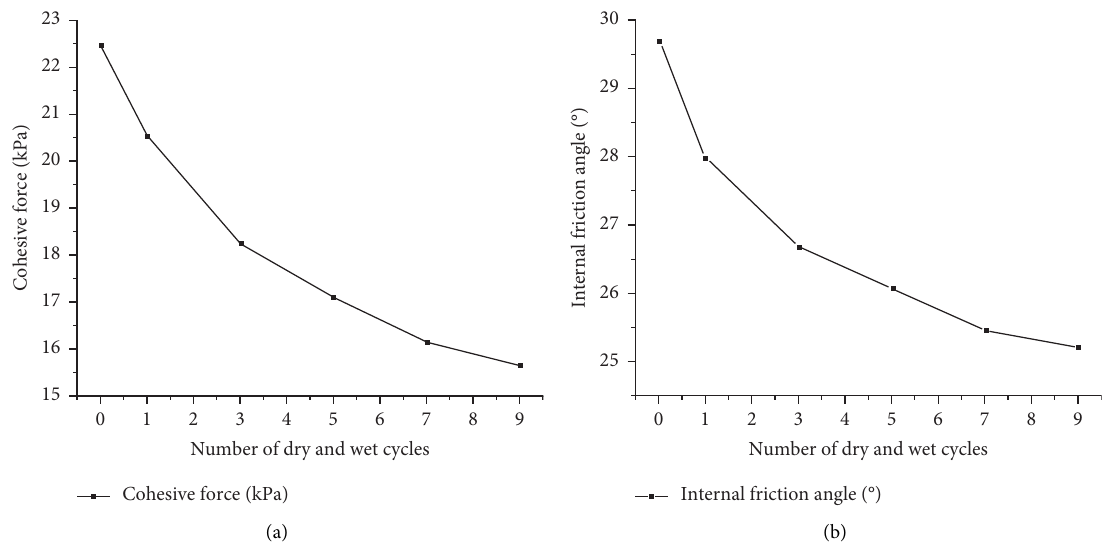
Figure 14: Relationship between c and φ parameters and different dry and wet